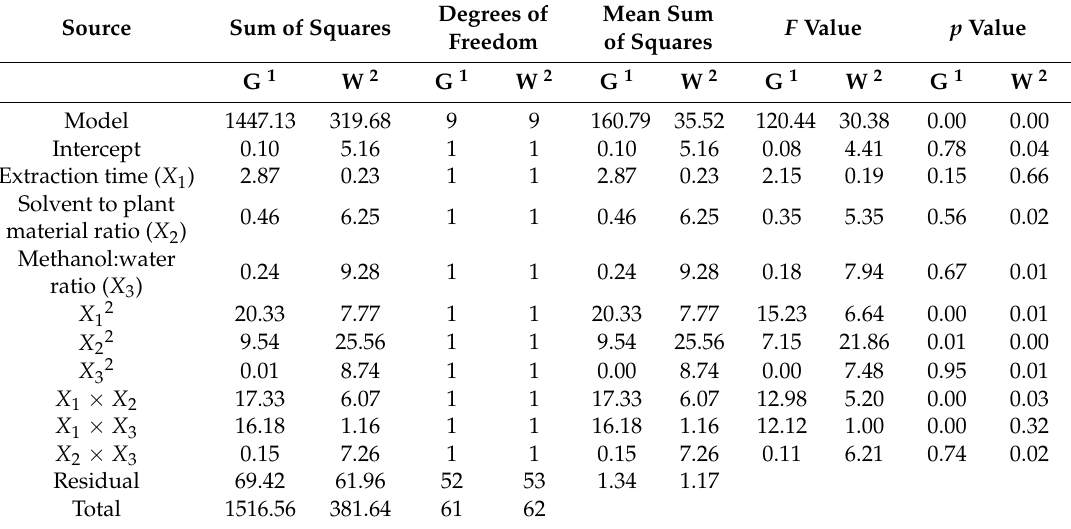
Table 3. Analysis of variance (ANOVA) for the total phenol content ( Y ) from leek extracts as a function of extraction time ( X 1 ), solvent to plant material ratio ( X 2 ), solvent mixture (methanol:water) composition ( X 3 ) and their